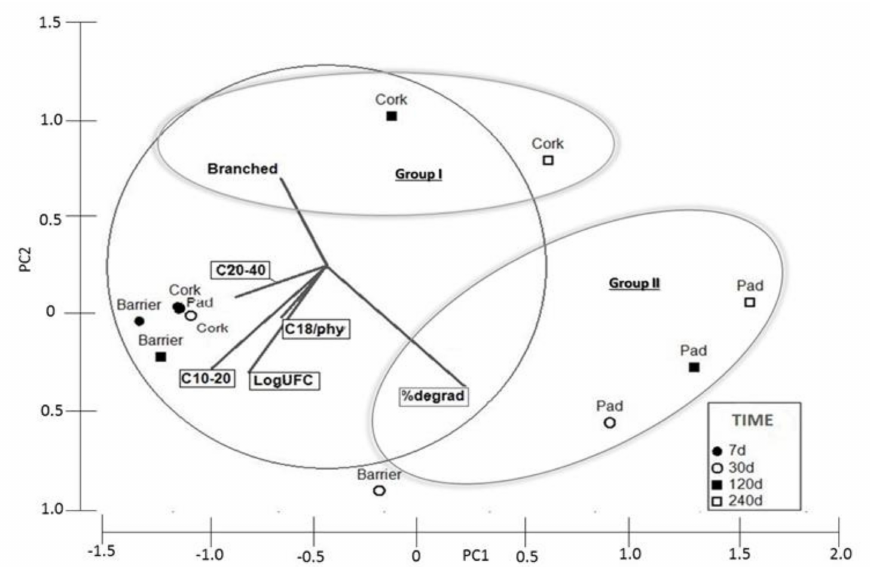
Figure 8. Principal component analysis (PCA) results for Pad Sentec ™ , CorkSorb ™ 01025 and Barrier Sentec ™ samples from each treatment, as well as biological and chemical data along straight lines for degradation of TPH, hydrocarbon fraction concentrations and indigenous